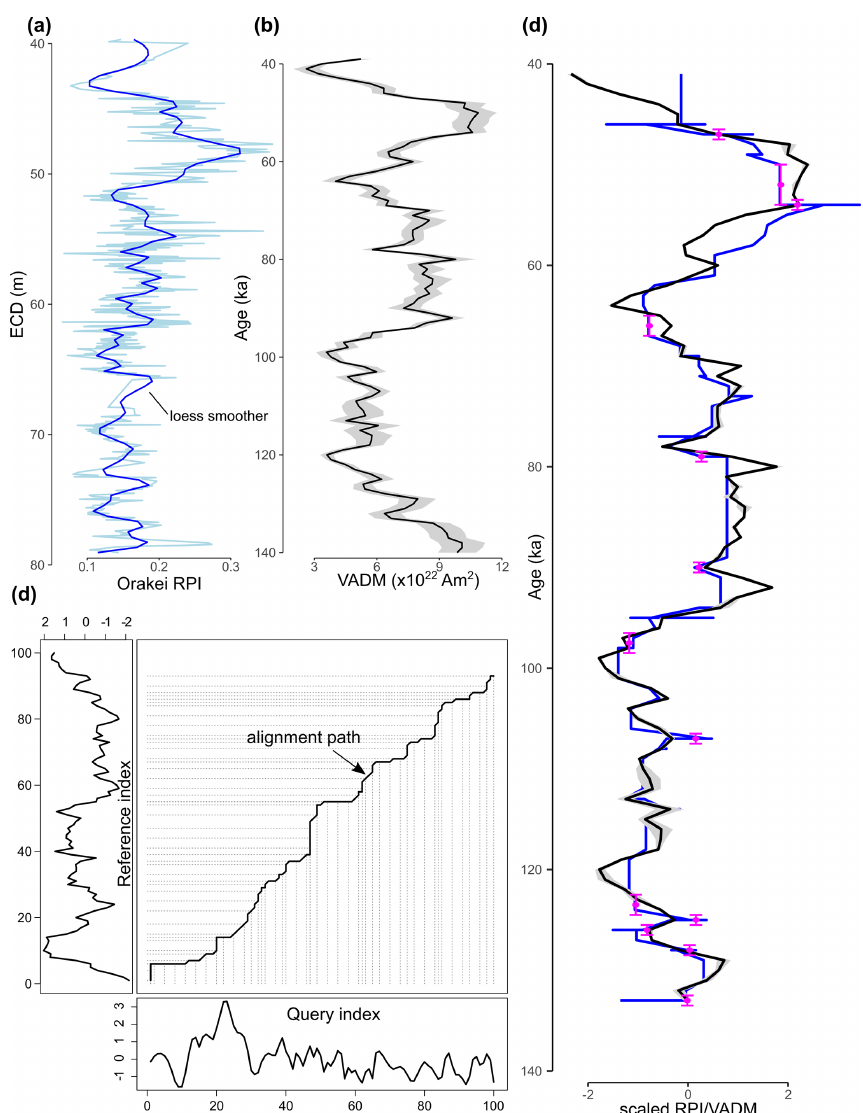
Figure 8. (a) Orakei RPI (NRM / ARM at 20mT, light blue) with loess smoother (dark blue). (b) PISO-1500 (Channell et al., 2009) ± standard error. (c) DTW alignment path (solid black line) with scaled Orakei RPI as the query curve below and scaled PISO- 1500 VADM as the reference curve to the left. Dotted grey lines highlight aligned points between both curves. (d) Both curves scaled after DTW alignment on the same age scale with selected random tuning points and age uncertainty of ± 2 σ